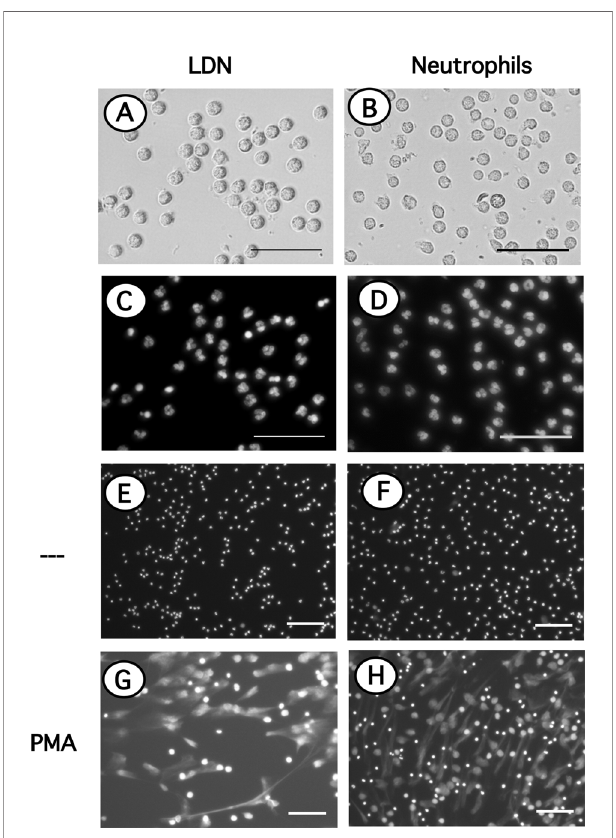
FIGURE 6 | Neutrophils and LDN have similar size, nuclear morphology and produce similar NET. Neutrophils puri fi ed by density gradient centrifugation and low-density neutrophils (LDN) puri fi ed by cell sorting were stained with DAPI to visualize only DNA (nuclei) by fl uorescence microscopy. LDN (A) ; bright fi eld) and neutrophils (B) ; bright fi eld) have similar size and nuclear morphology (C, D) . LDN (E, G) or neutrophils (F, H) were left untreated ( — ), or were stimulated with 20 nM PMA. After four hours cells were stained with DAPI to visualize neutrophil extracellular traps (NET). Images are representative of 2 experiments with similar results. Scale bar represents 50 µm (A – D) , or 100 µm (E – H) .